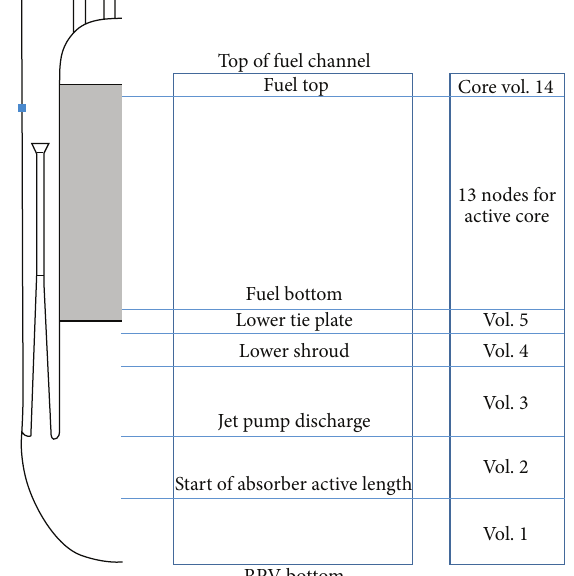
Figure 7: Schematic of the nodalization model of core and sections of RPV below